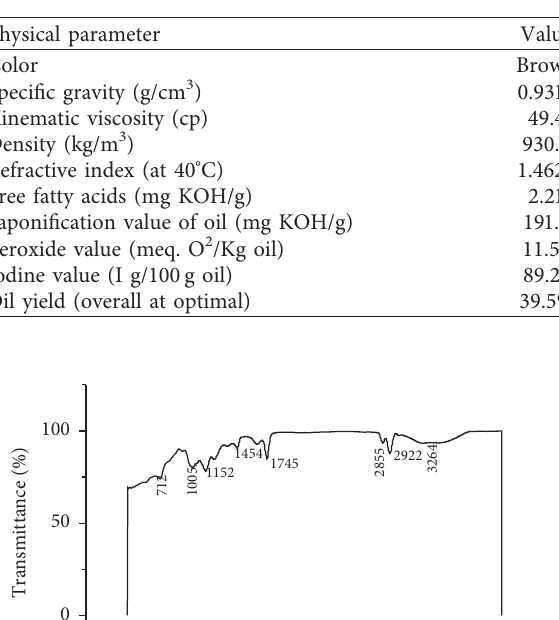
Table 6: Summary of physicochemical properties of obtained